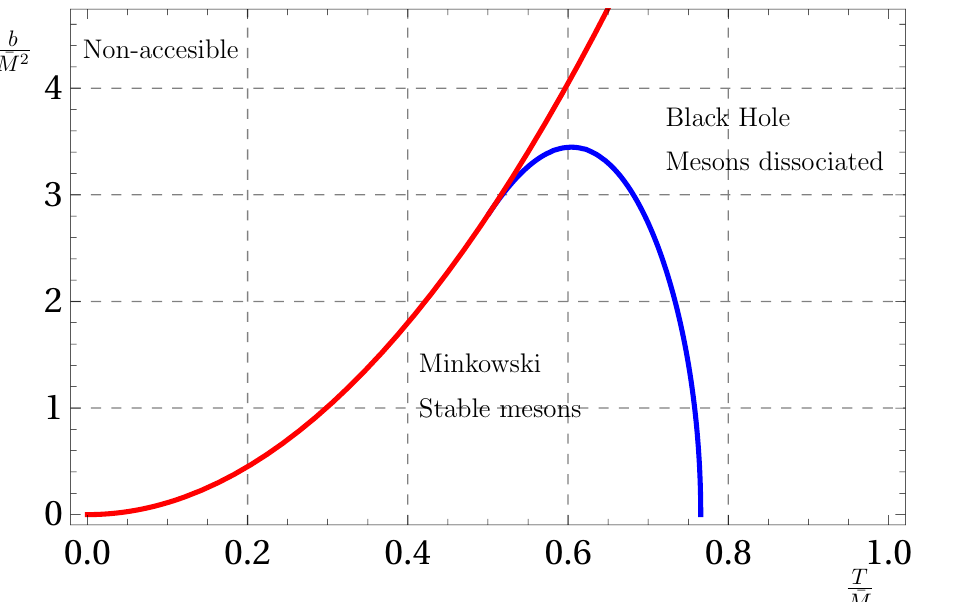
Figure 1 . Phase diagram of the (cid:13)avor D7-branes. The red curve indicates the critical value b=T 2 = 11 : 24, thus the region to its left it’s not accesible with our gravitational backgrounds. The blue curve denotes the interphase between the two types of embeddings. The maximum of the blue curve is located at b= (cid:22) M 2 = 3 : 44 and T= (cid:22) M = 0 : 604. The intersection of both curves is located at b= (cid:22) M 2 = 2 : 82 and T= (cid:22) M = 0 :